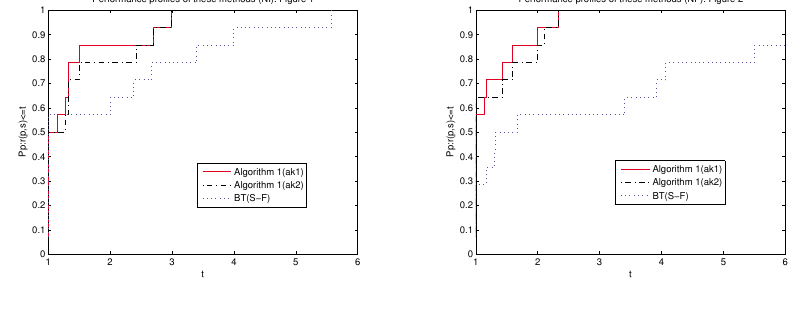
Figure 1. Performance of NI. Figure 2. Performance of NF.